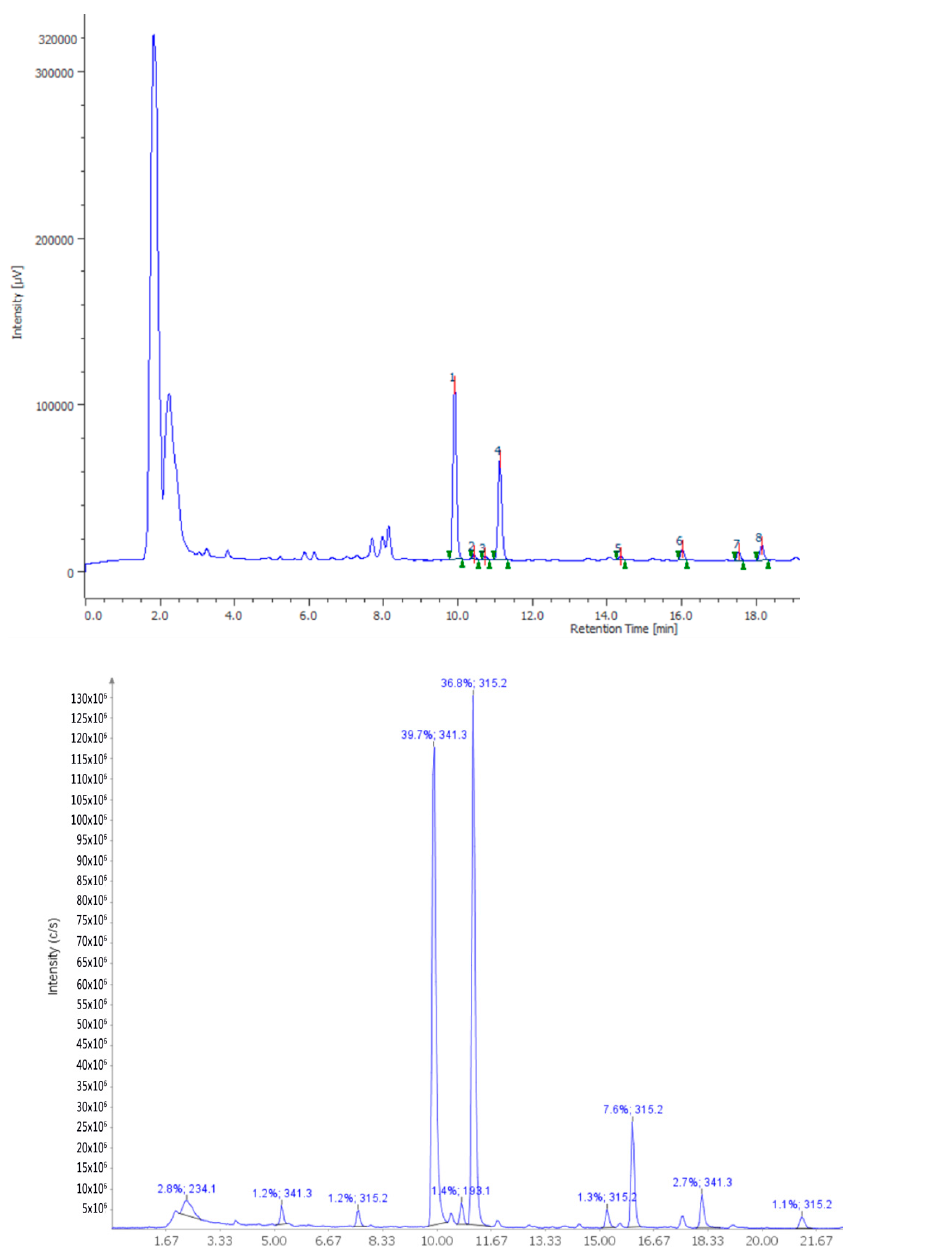
Figure 2. Chromatographic analysis of Futura 75 terpenophenols, in the water extract. ( A ) HPLC-UV chromatogram; ( B ) HPLC-MS chromatogram. In both subfigures cannabidiolic acid (1) and cannabidiol (4) areas are prominent compared to the other identified compounds.